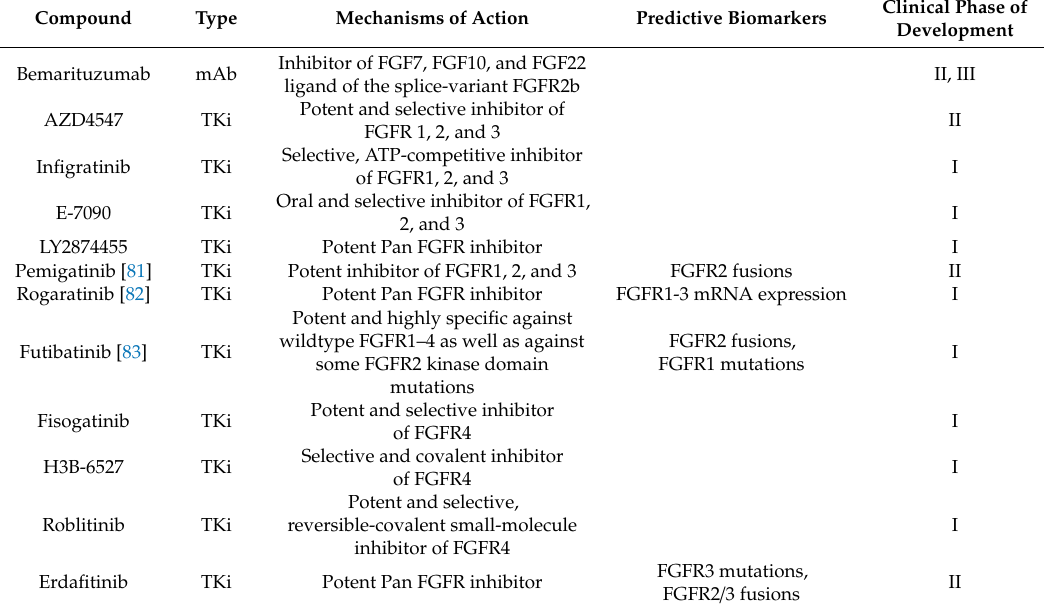
Table 4. FGFR inhibitors under